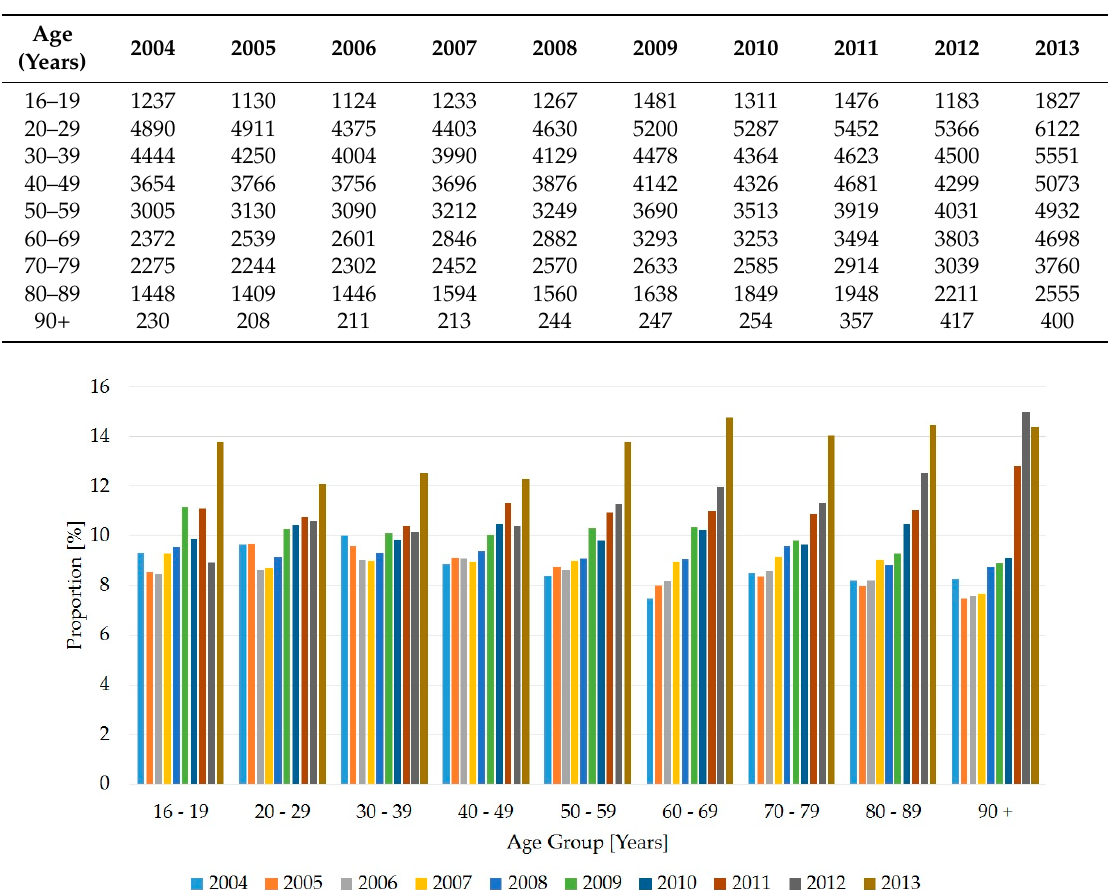
Table 3. Absolute patient numbers, by age group (years) and years ( N = 264,272 persons).